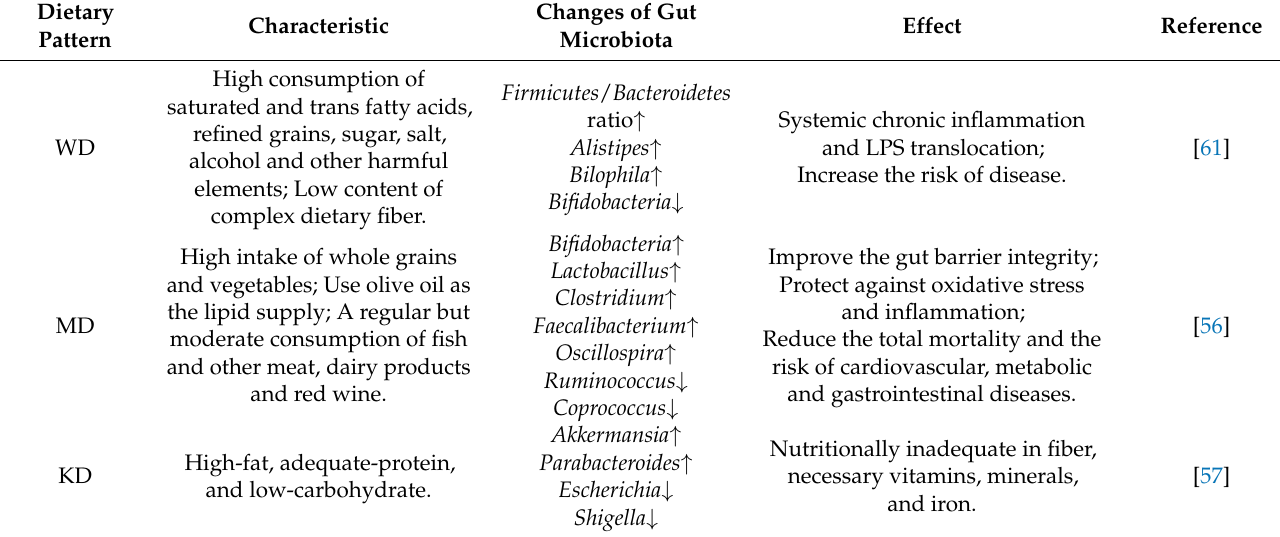
Table 1. The effect of dietary patterns on health mediated by gut